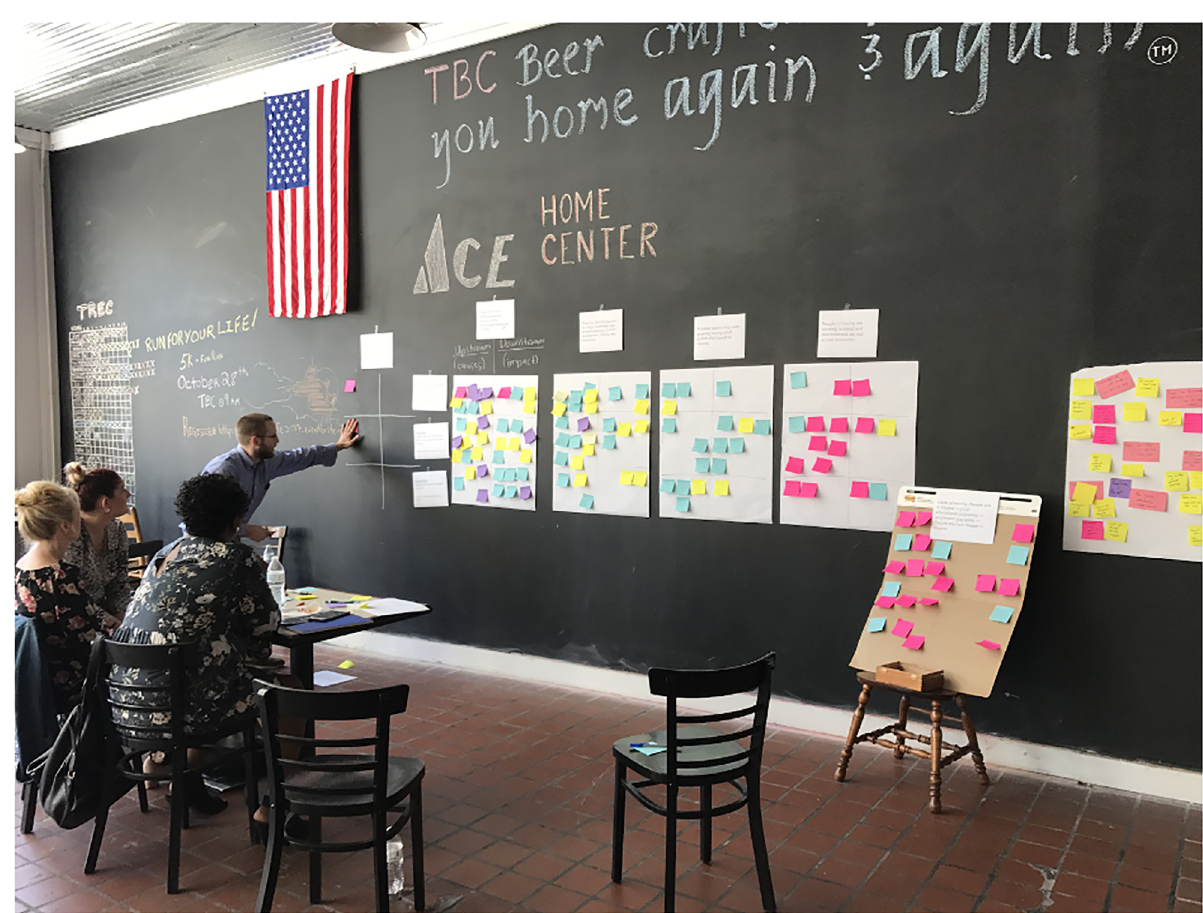
Fig 1. A meeting engaging community members to brainstorm ideas for the